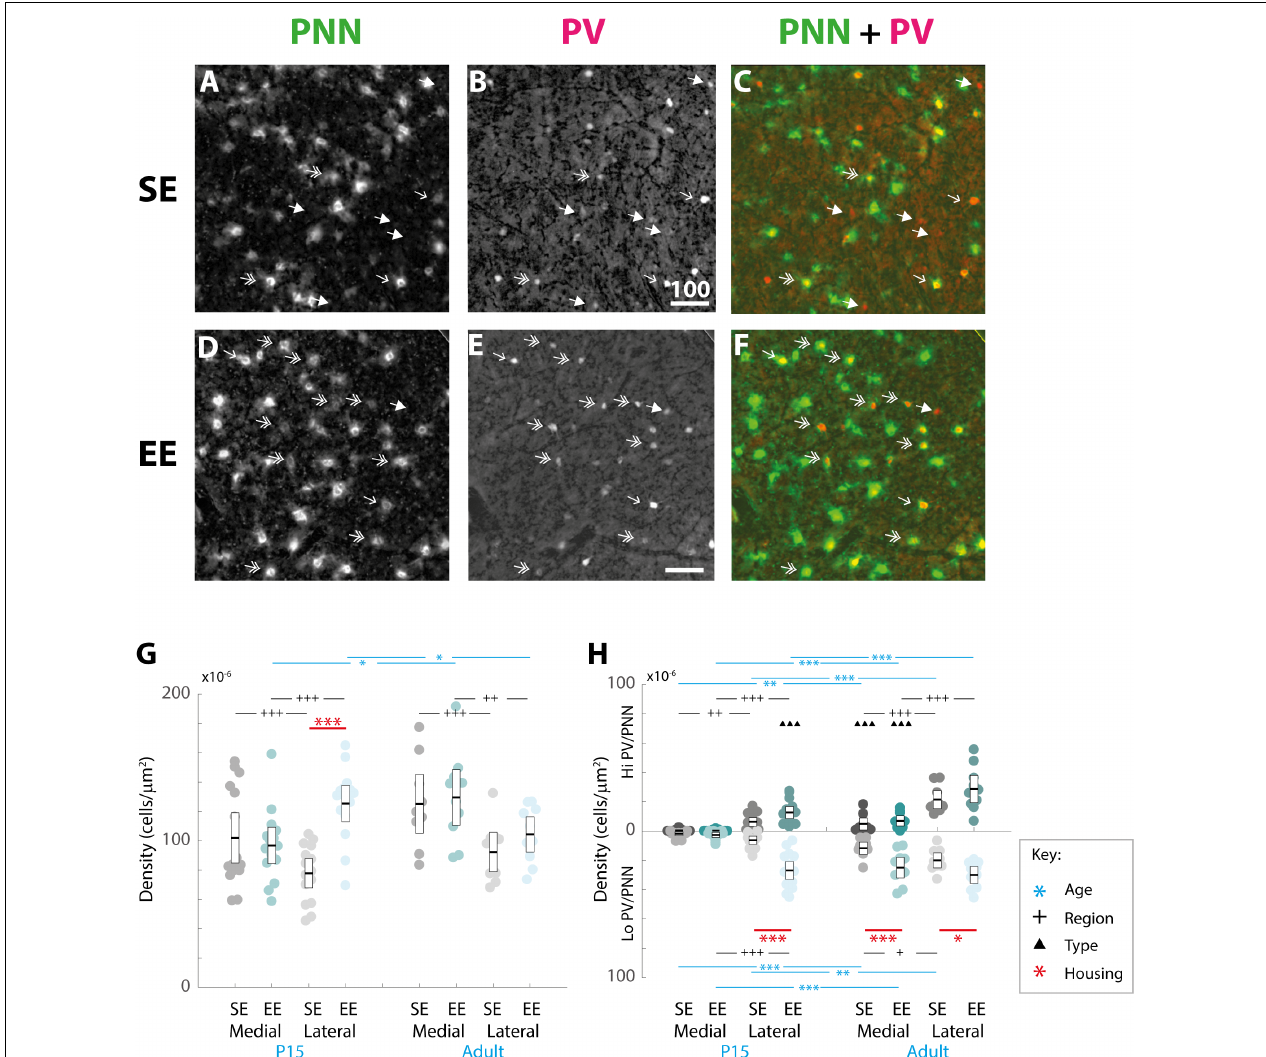
FIGURE 3 | Age, region, cell type, and housing conditions affect PNN and PV/PNN overlap differently in the developing and adult striatum. (A–F) Images showing the pattern of PNN (WFA) staining (A,C) , PV expression (B,E) , and their overlap (C,F) in the lateral striatum of adult mice raised in standard (SE; top row) and enriched (EE: bottom row) housing. Both Hi PV (single-headed, unfilled arrows) and Lo PV (double headed arrows) cells are detectable in SE and EE samples. Unlike in cortex, only a partial overlap between PV cells and PNNs is observed in the striatum. Filled arrows indicate PV-positive cells that are not encapsulated by PNNs. Overall, PV cell density appears to have increased in the EE section (compare E to B ), while little or no difference is observable for PNNs (compare D to A ). Scale bar (in image): 100 µ m. (G) Striatal PNN density (counts per micrometer 2 ) in standard (SE) and enriched (EE) mice at all ages assessed. Conventions are identical to those in Figure 2 . Blue bars and asterisks (Age): No differences in PNN densities by age were revealed in either region for SE samples (SE by age, p > 0.07 for medial and lateral domains). A significant increase in adult compared to P15 PNN levels was, however, detected in medial striatum in EE mice (Adult > P15: p = 0.010). Curiously, lateral densities exhibited a significant decrease with age in this cohort (P15 > Adult: p = 0.019). Black bars and crosses (Regions): Significant differences were observed between striatal regions, with medial densities greater than lateral for P15 SE samples (Medial > Lateral, p < 0.001). EE pups exhibited the opposite bias at this age point (Lateral > Medial, p < 0.001). For adult samples, both SE ( p < 0.001) and EE ( p = 0.002) groups exhibited greater medial PNN densities. Red bars and asterisks (Housing): At P15, significantly greater PNN densities were detected in EE relative to SE samples in lateral striatum ( p < 0.001). Differences between housing groups, however, were not maintained in adult samples for either striatal region. Means (solid bar) and standard errors of the mean (s.e.m.; extent of white boxes) are depicted. Individual values are depicted as coloured circles: darker greys: medial SE; darker cyans: medial EE; lighter greys: lateral SE; lighter cyans: lateral EE. ∗ p < 0.05; ∗∗ p < 0.01; ∗∗∗ p < 0.001; + p < 0.05; ++ p < 0.01; +++ p < 0.001. (H) Density (counts per micrometer 2 ) of PV/PNN overlap in SE and EE mice at all age points assessed. Blue bars and asterisks (Age): Across ages, overlap with both Hi (Medial: p = 0.005; Lateral: p < 0.001) and Lo PV cells (Medial: p < 0.001; Lateral: p = 0.001) were significantly greater in adults compared to P15 mice, in both medial and lateral striatum for SE cohorts. In EE mice, both Hi PV/PNN (EE: Hi PV/PNN: p < 0.001) and Lo PV/PNN (Lo PV/PNN: Adults > P15, p < 0.001) overlap was significantly higher in adults compared to P15 samples in medial striatum. Significantly greater densities were also detected for adult Hi PV/PNN ( p < 0.001) but not Lo PV/PNN ( p = 0.403) associations in the lateral region. Black bars and crosses (Regions): Overlap in lateral compared to medial regions was significantly higher for Hi PV cells in both SE ( p = 0.009) and EE samples ( p < 0.001). Overlap densities in lateral striatum were greater for Lo PV cells only in EE samples at the same age ( p < 0.001). A similar trend was observed in adult samples, with greater Hi PV/PNN associations detected in lateral compared to medial striatum for SE ( p < 0.001) and EE ( p < 0.001) groups. Regional differences in (Continued)